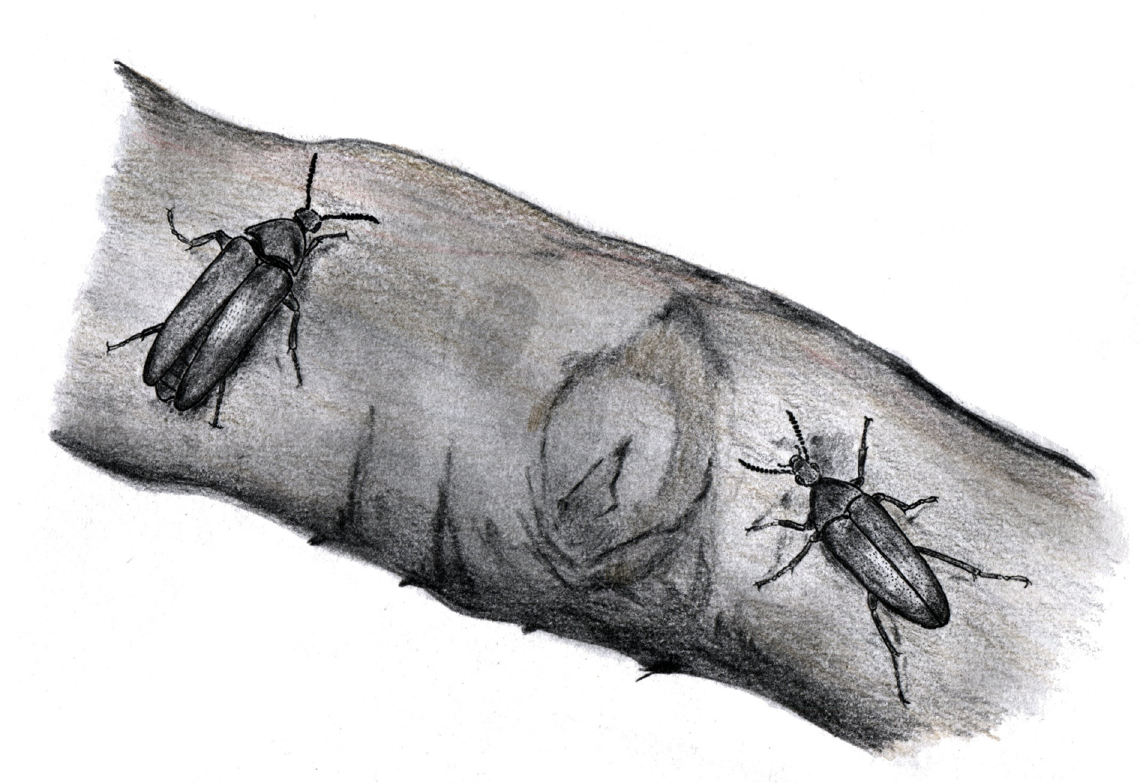
Fig. 6. A reconstruction of Archaeoripiphorus nuwa Hsiao, Yu & Deng gen. et sp. nov., illustrating a hypothesized behavior in which the females search for damaged xylem cells, caused by larvae of xylophagous beetles, to oviposit